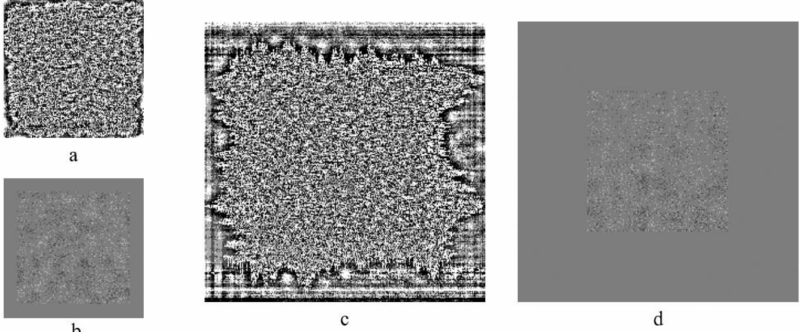
Figure 11. Quantized decrypted images ( a , c ) and error maps ( b , d ) for MCDDCs with 128 × 128 ( a , b ) and 254 × 254 ( c , d ) elements.